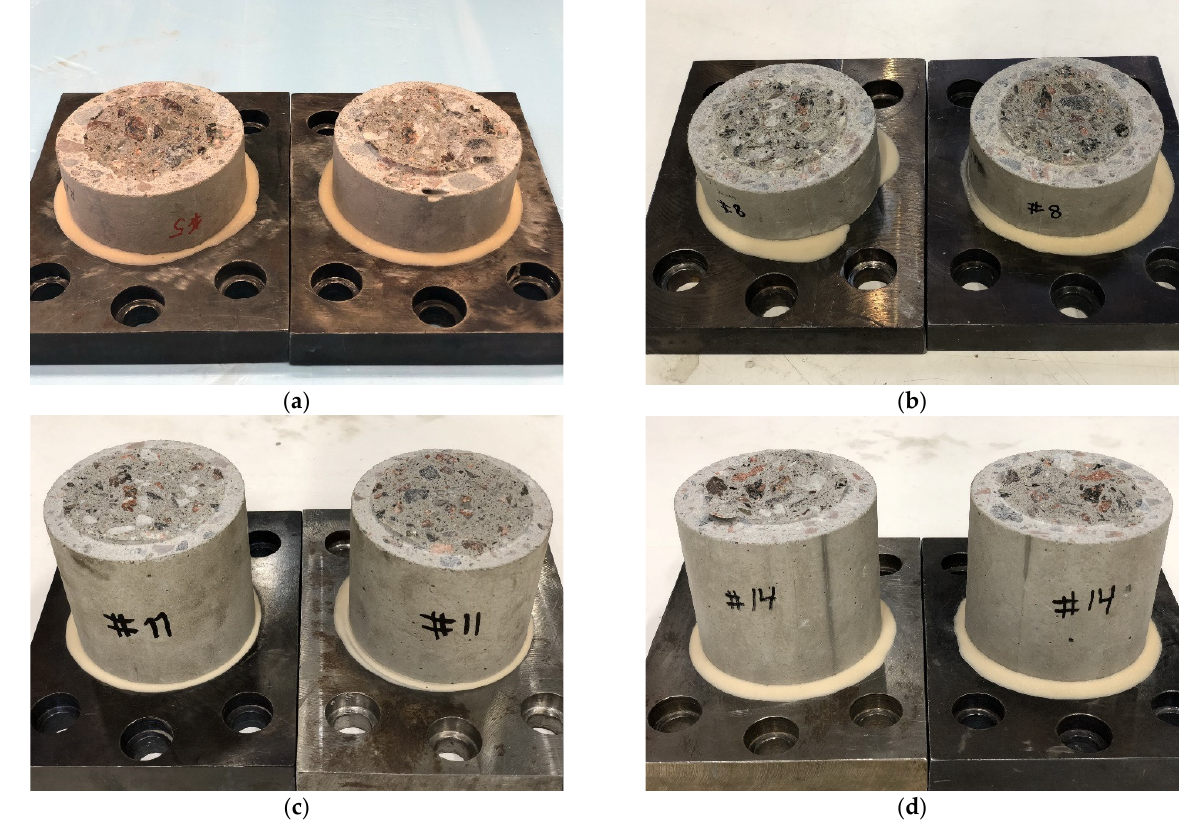
Figure 5. Failure patterns of four tensile tested concrete samples; ( a ) Sample #5, H100D70, ( b ) Sample #8, H100D70, ( c ) Sample #11, H200D80, and ( d ) Sample #14, H200D70.